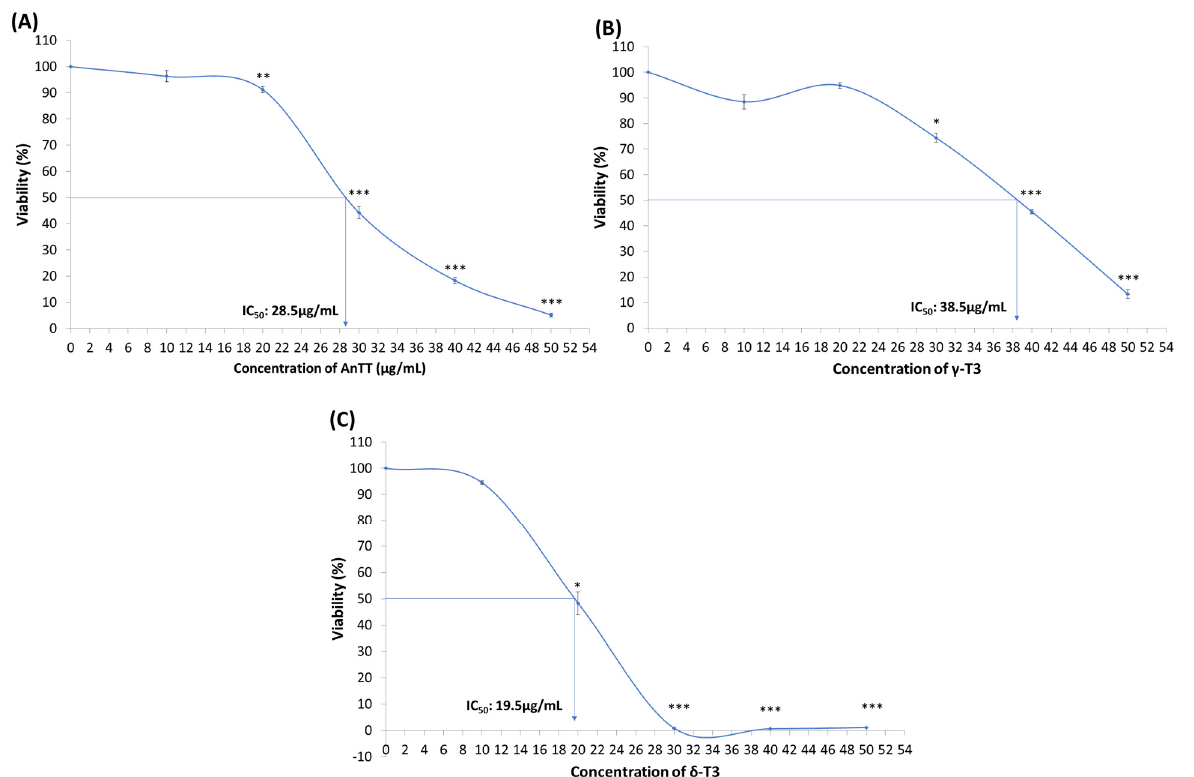
Figure 1. The cytotoxicity of AnTT ( A ), γ -T3 ( B ) and δ -T3 ( C ) on SW1353 cells upon 24 h treatment. *, ** and *** indicate a significant difference of p < 0.05, p < 0.01 and p < 0.001 compared to VC. The viability of VC is assumed as 100%. Abbreviations: AnTT, annatto tocotrienol; δ -T3, δ -tocotrienol; γ -T3, γ -tocotrienol; IC 50 , half-maximal inhibitory concentration; VC, vehicle control.